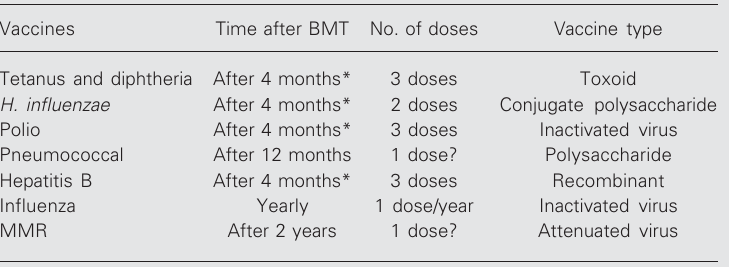
MMR = measles, mumps and